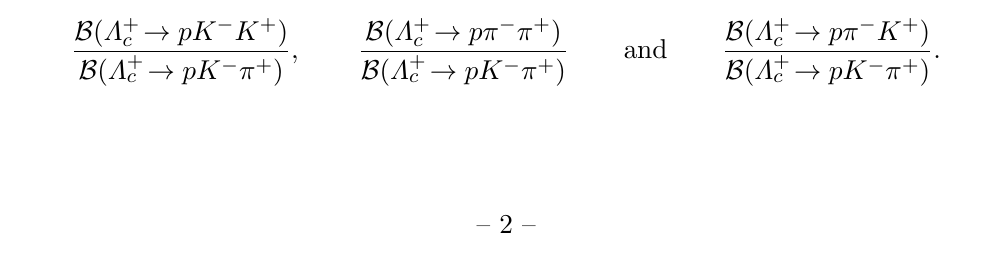
to a proton and two mesons, without hyperon mediation. Shown c ! pK (cid:0) (cid:25) + and (b) (cid:3) + c ! p(cid:25) (cid:0) K + , and W -exchange for (e) (cid:3) + c